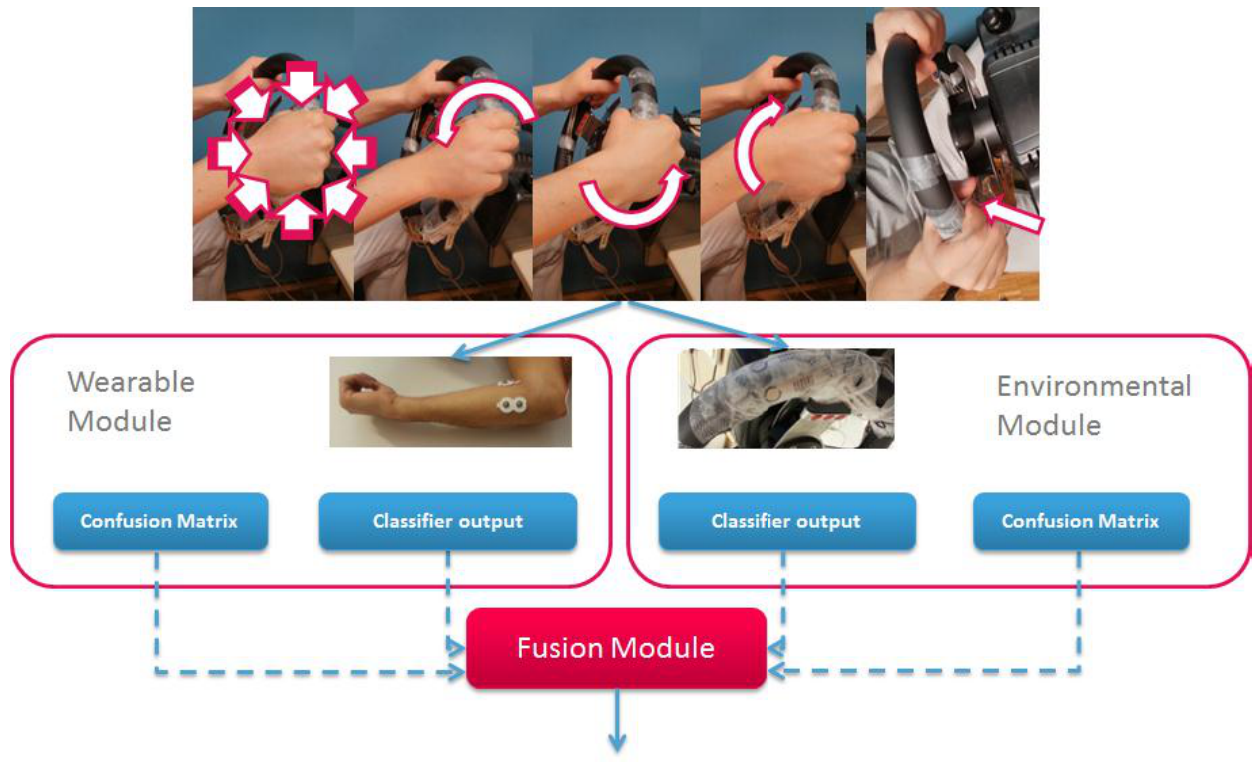
Figure 8. Hybrid WheelSense System and the five gestures (top): fist squeeze, wrist extension, wrist flexion, hand push, index tap.